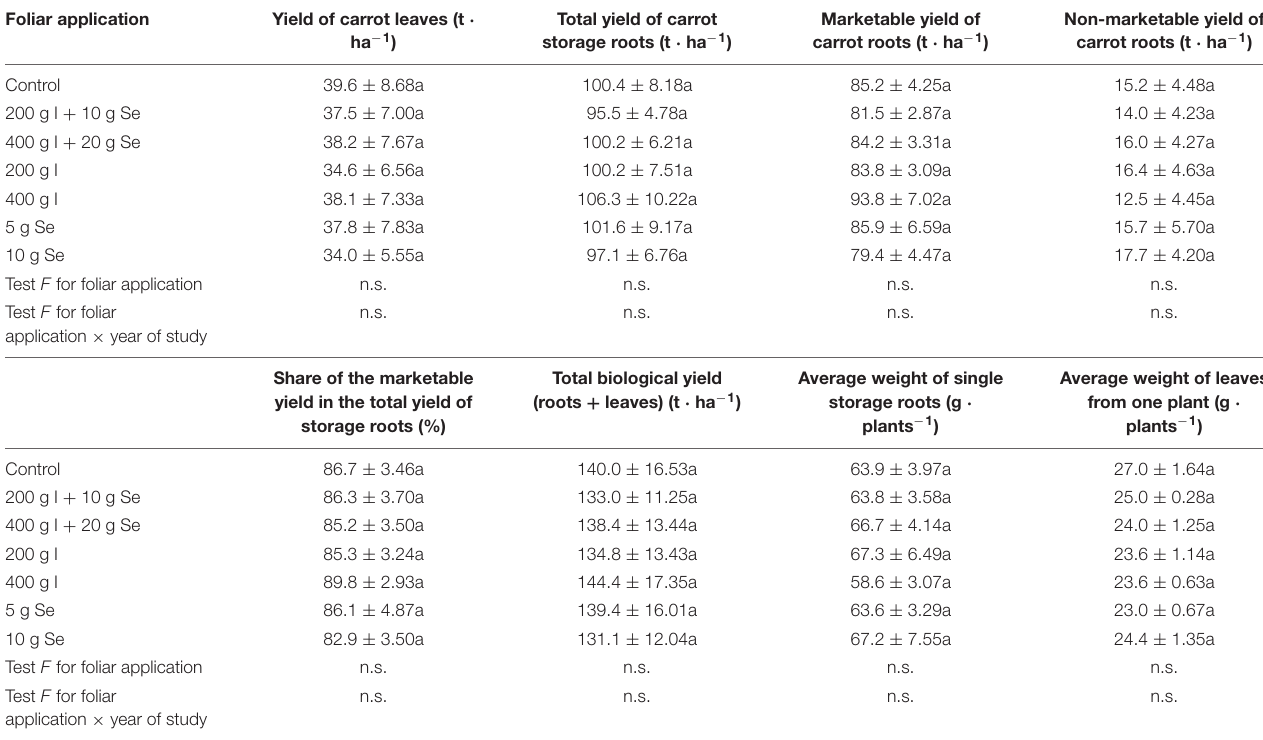
TABLE 4 | Yield of leaves and storage roots, share of the marketable yield in the total yield, and average weight of single storage roots and leaves from one plant, depending on the foliar application of iodine and